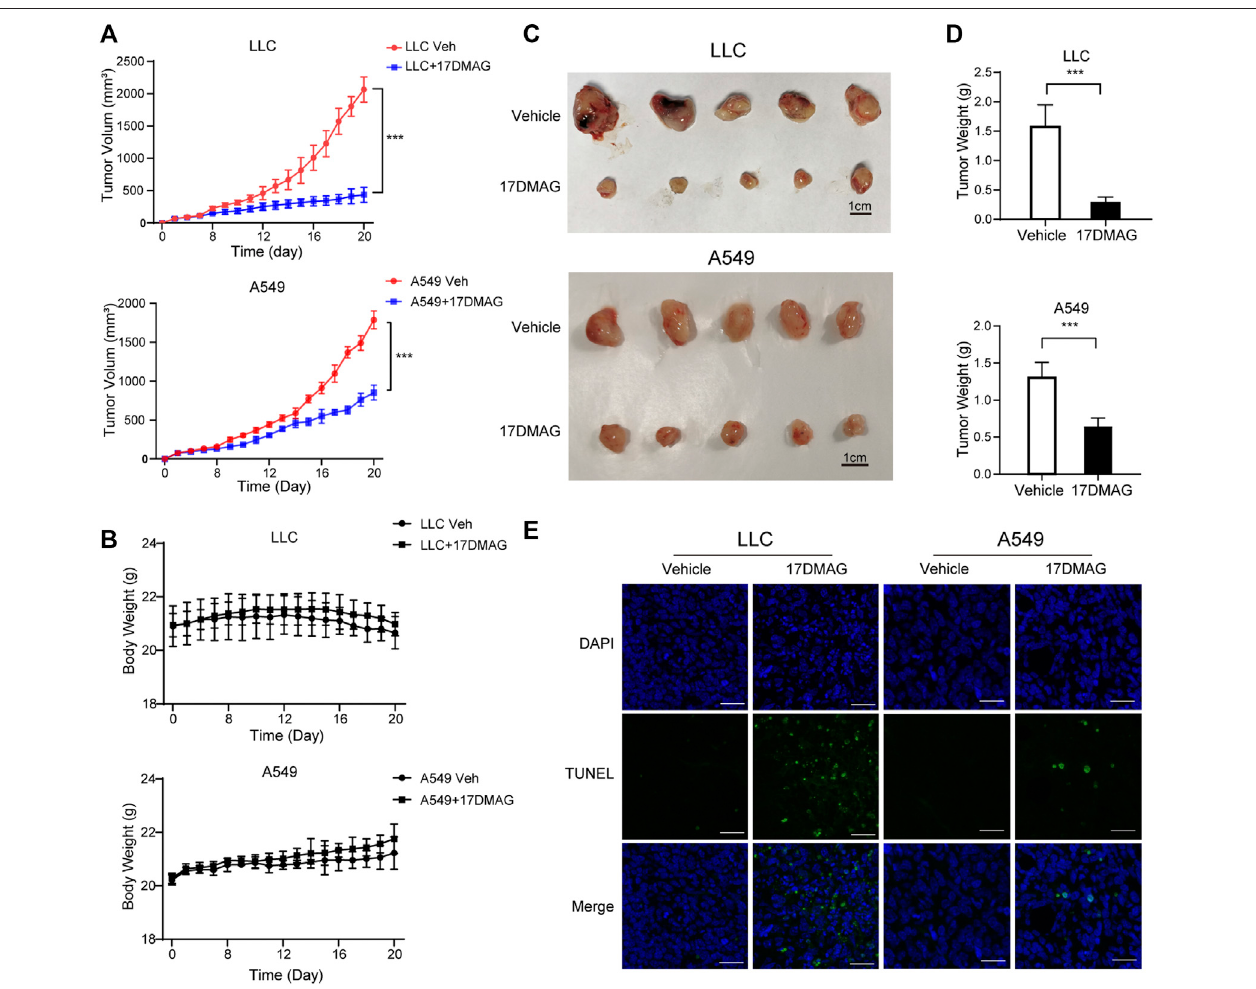
FIGURE 7| 17-DMAG inhibited tumor growth and induced cell death in vivo . Male C57/BL6 and Balb/c nude mice (n (cid:1) 10) were injected with LLC and A549 cells, respectively( n (cid:1) 10).Aftertumorsreachedapproximately100 mm 3 ,miceweretreatedwithorwithout17-DMAG(15 mg/kg/day)intraperitoneally. (A) Tumorvolumesof LLC and A549 bearing mice were calculated every day. *** p < 0.001. (B) The weight of each LLC or A549-bearing mouse was measured every other day before the treatment of 17-DMAG ( n (cid:1) 5 per group). (C) Tumor mass images of both LLC and A549 model mice at the end of the experiment ( n (cid:1) 5 per group). (D) LLC and A549 tumors treated withorwithout17-DMAGwere removedand weighedafter theeuthanasiaofmice.*** p < 0.001. (E) Analysisofapoptosis byTUNEL staining(blue fl uorescence, DAPI staining for nuclei; green fl uorescence, TUNEL-positive staining) in LLC and A549 cell xenograft mouse-derived tissue from control, 17- DMAG – treated animals. Scale bar (cid:1) 50 μ